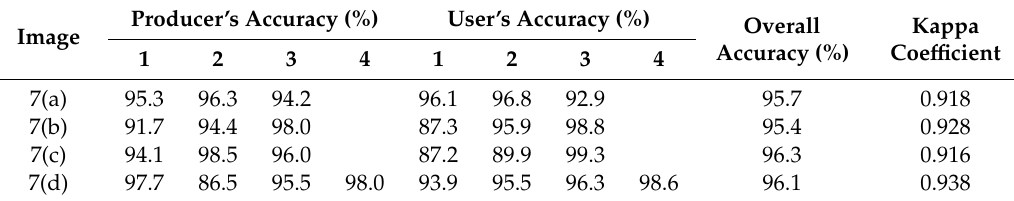
Figure 9. Temples of real SAR images: ( a – d ) Temple images. Table 4. Quantitative evaluation of a simulated SAR image.